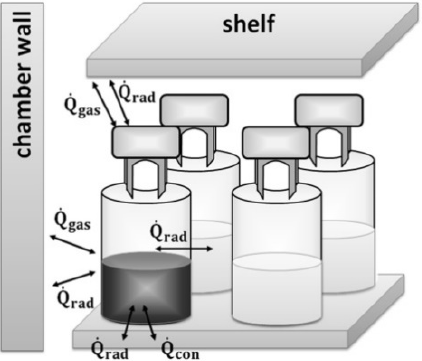
Figure 5. Energy transfer of a separated corner vial.